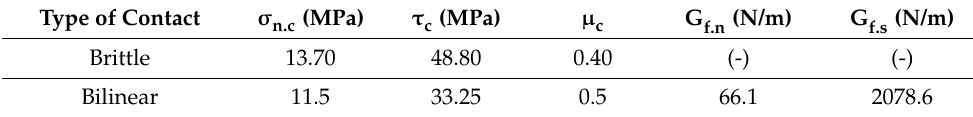
Table 2. Contact strength properties for the particle models